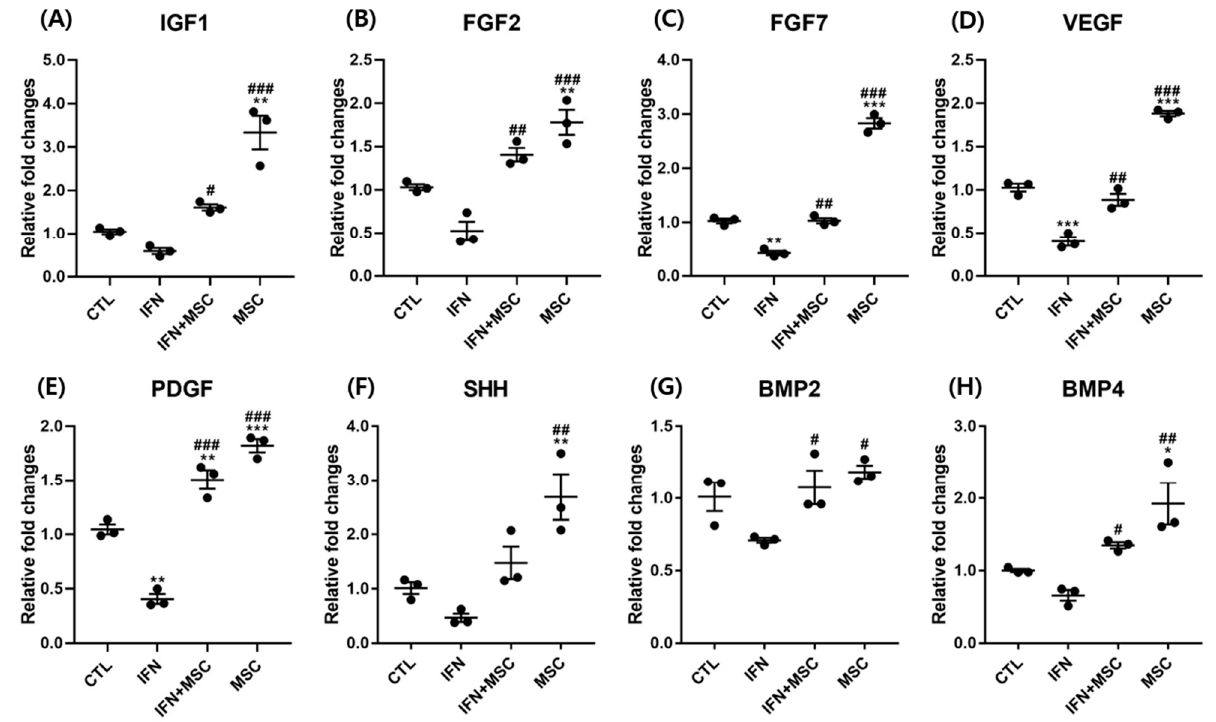
Figure 6. Analysis of gene expression by RT-PCR. Effects of hHMSC treatment on hair-growth-related growth factors. hHMSC treatment significantly upregulated the mRNA of various growth factors including ( A ) IGF1, ( B ) FGF2, ( C ) FGF7, ( D ) VEGF, ( E ) PDGF, ( F ) SHH, ( G ) BMP2 and ( H ) BMP4 which were suppressed by IFN- γ . Error bars represent the mean ± SEM, n = 3. Statistically significant at * p <0.05, ** p < 0.01 and *** p < 0.001, compared to the controls and # p < 0.05, ## p < 0.01 and ### p < 0.001 compared to the IFN- γ -treated